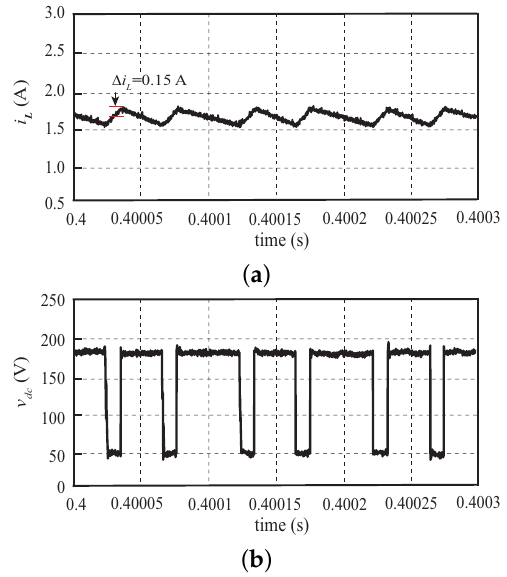
Figure 11. Z-source network waveform. ( a ) Inductive current ( b ) DC link